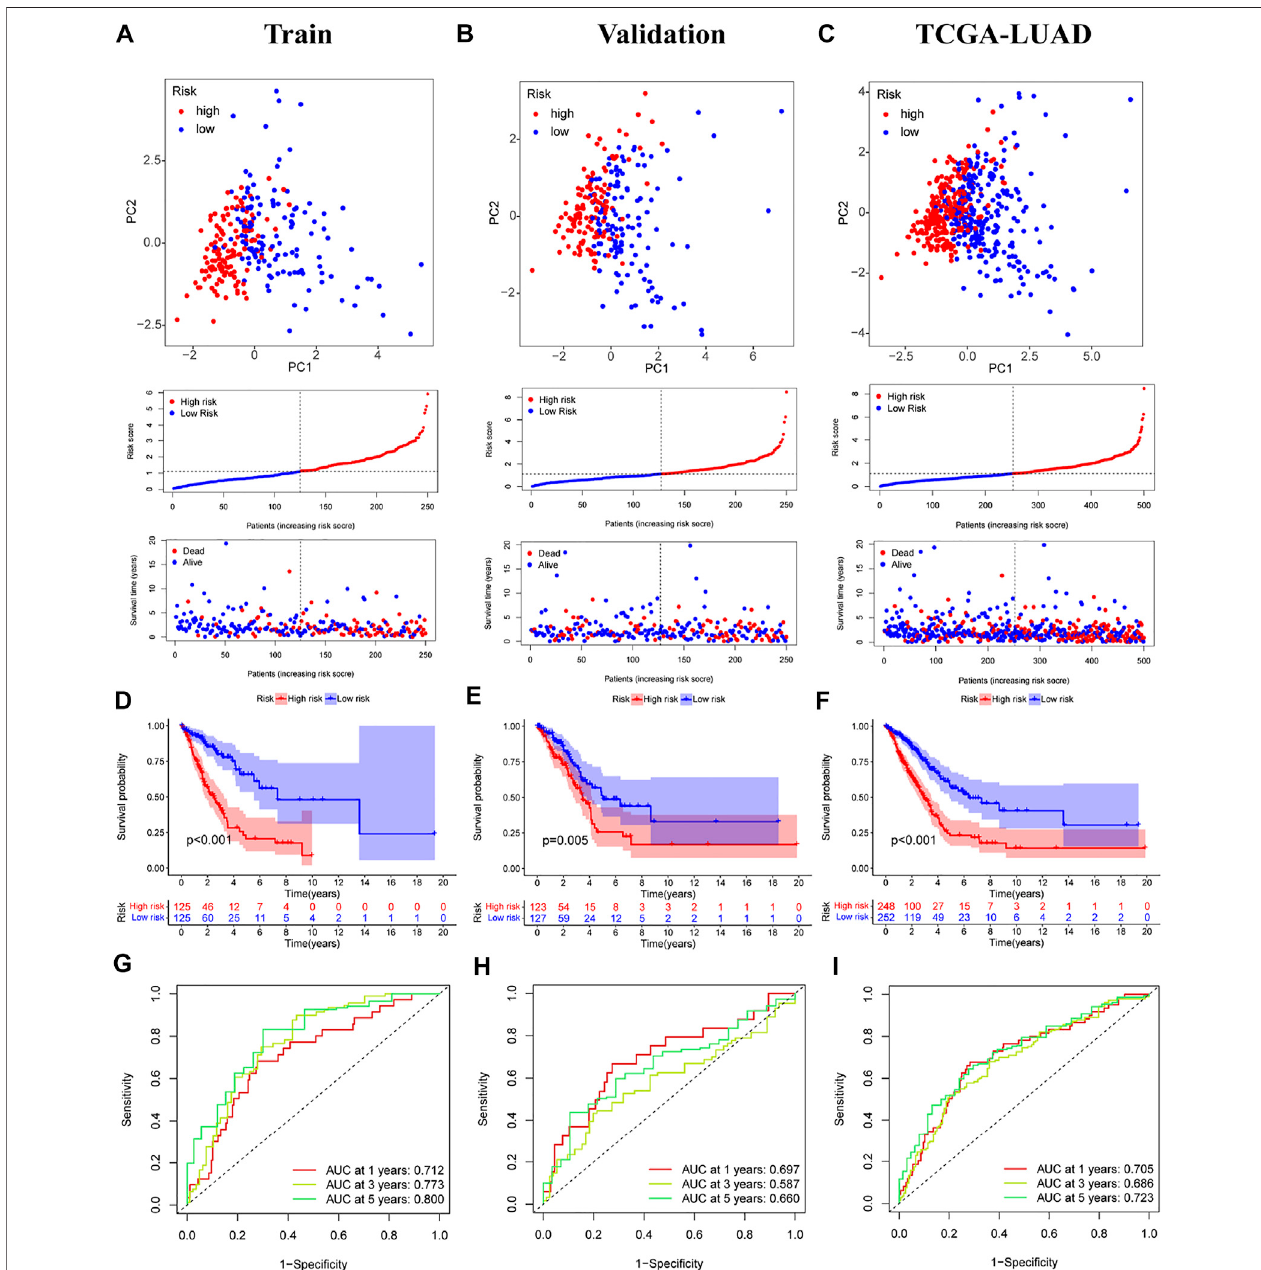
FIGURE 4 | Validation of prognostic models for six m7G-related lncRNAs. (A – C) Principal component analysis, risk score distribution, and survival status distribution for training, validation, and TCGA-LUAD. (D – F) Kaplan-Meier curves of training group, validation group and TCGA-LUAD at different risk groups. (G – I) ROC curves for 1 year, 3 years and 5